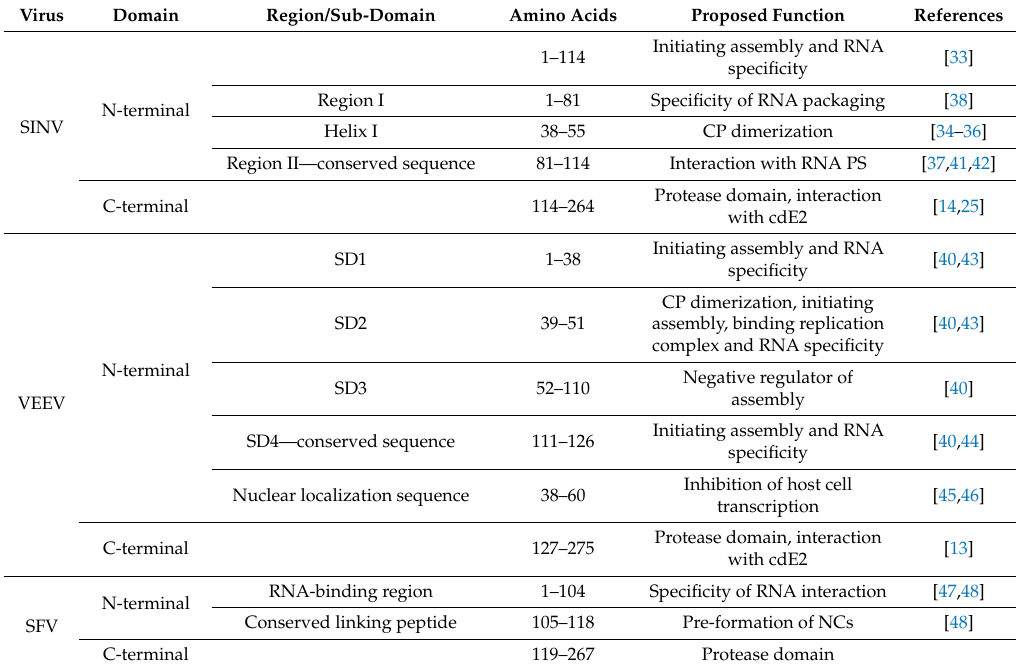
Table 1. Description of the domains and regions associated with NC assembly of three commonly referenced